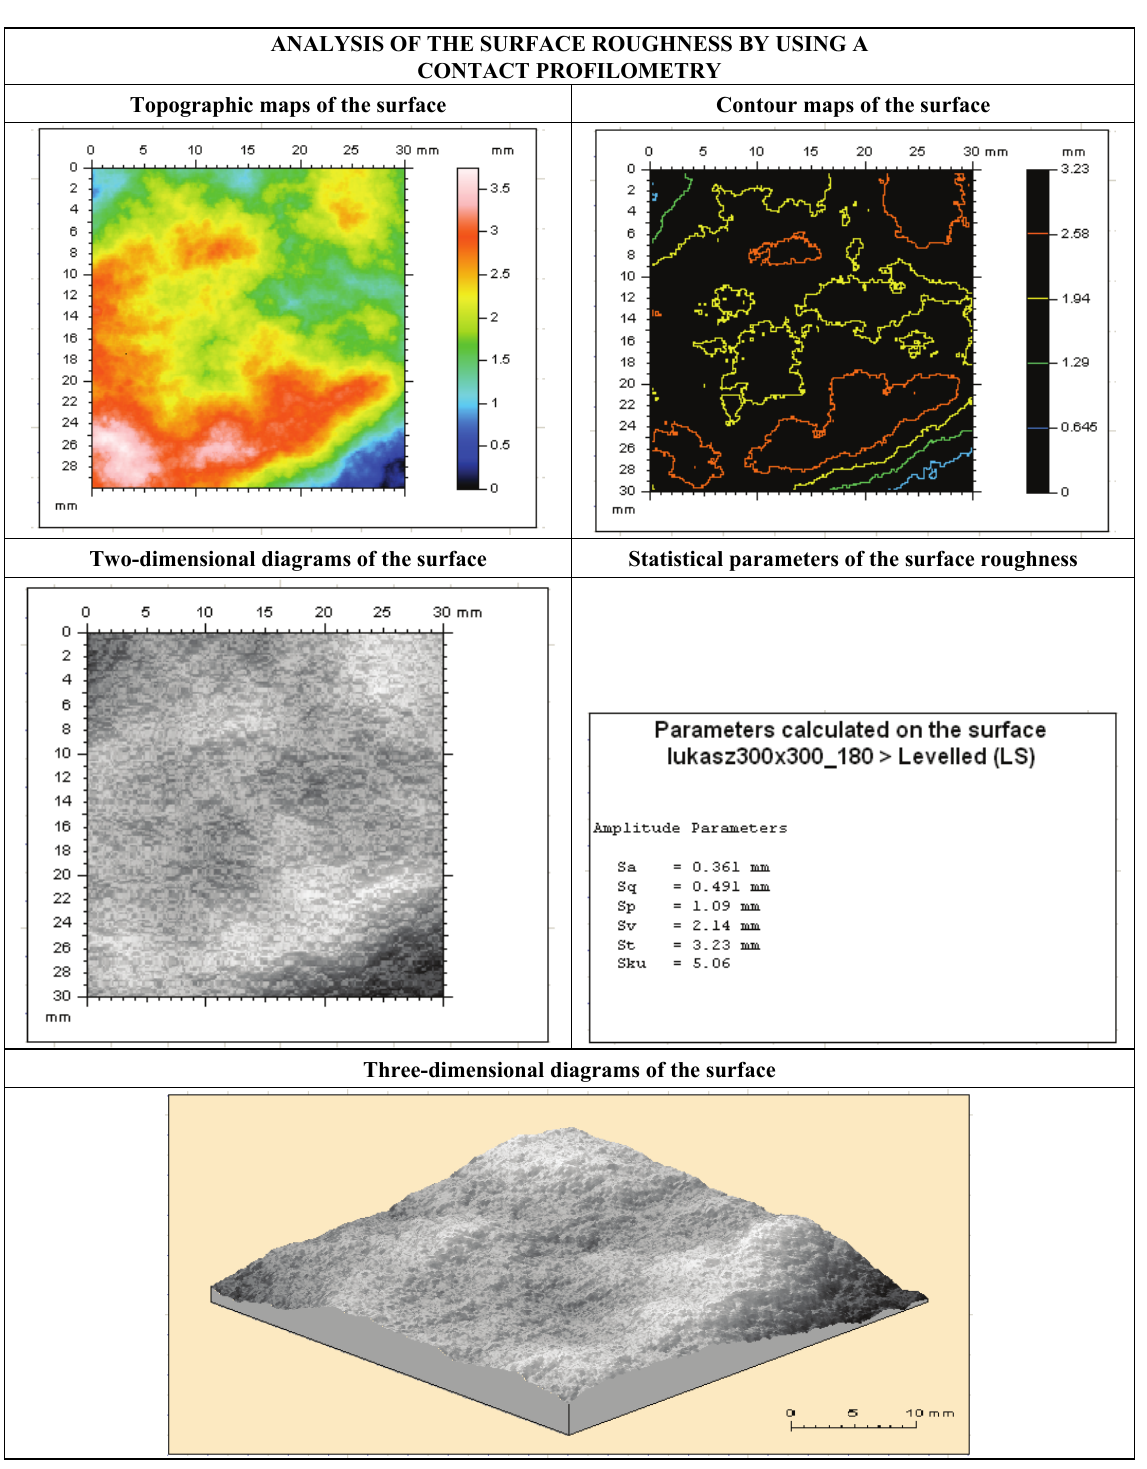
Fig. 4. Varied examples of visualization of the data collected from the cleaved